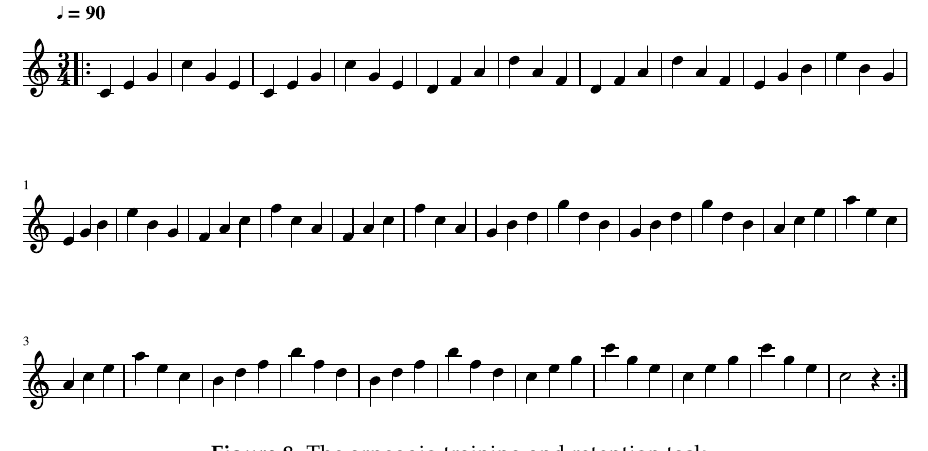
Figure 8. The arpeggio training and retention task.